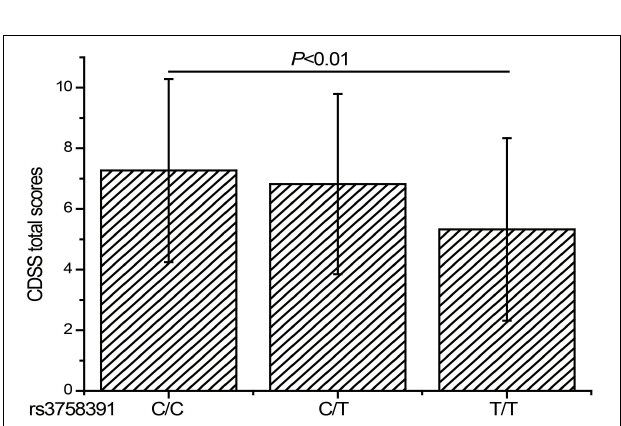
FIGURE 3 | CDSS scores of schizophrenia patients classified according to the genotypes of rs3758391 polymorphism. Each column represents the mean ± SD. C/C ( n = 25), C/T ( n = 207), and T/T ( n =